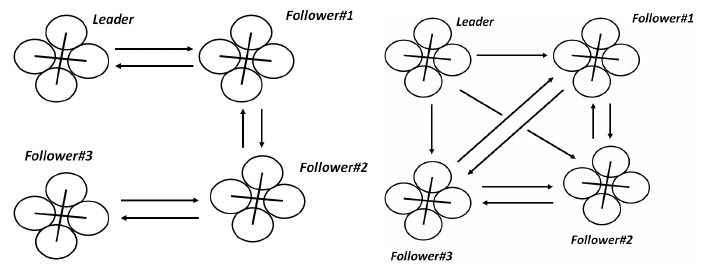
Figure 1. Network structure comparison: ( a ) network structure adopted in Reference [13]; ( b ) network structure adopted in this